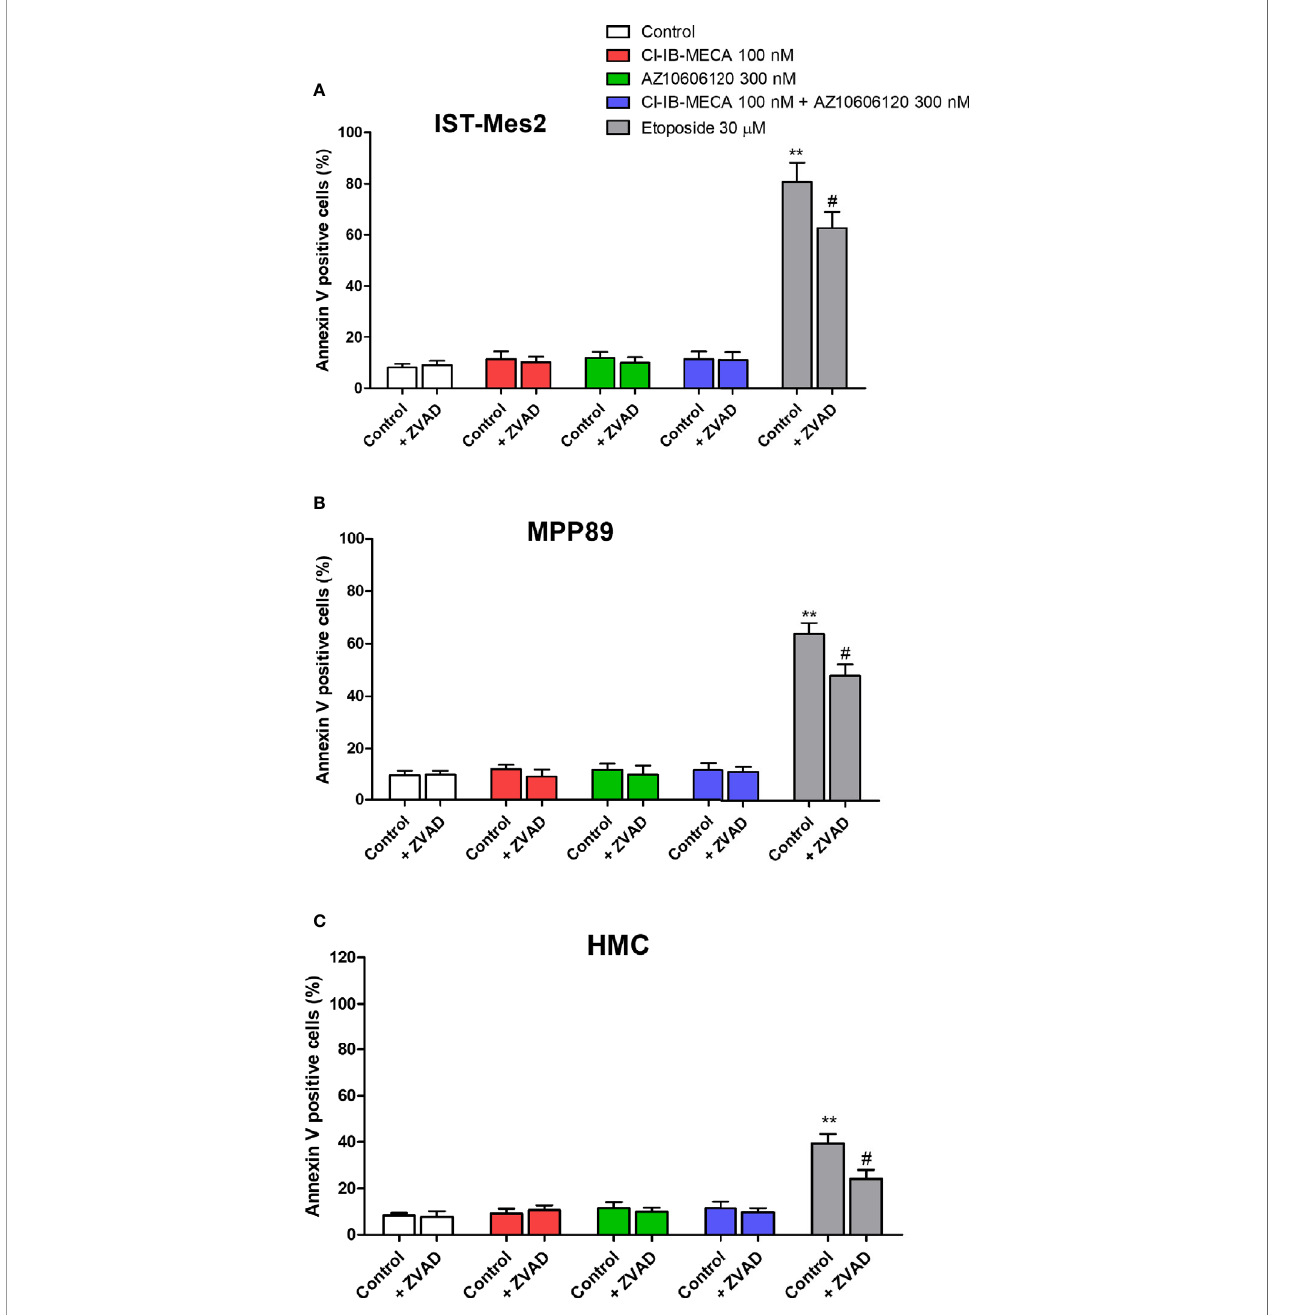
FIGURE 6 | Annexin V assay. Effect of Cl-IB-MECA (100 nM), AZ10606120 (300 nM), alone or in combination, in comparison to etoposide 30 µM on the percentage of Annexin V positive cells in IST-Mes2 (A) and MPP89 (B) cells as well as in HMC cells (C) . Treatments were performed in the absence or in the presence of ZVAD- FMK (ZVAD, 50 µM) as a pan-caspase inhibitor. Results are represented as mean ± standard error of mean (SEM) of n=3 independent experimental replicates. **p < 0.01 vs control; # p < 0.05 vs etoposide 30